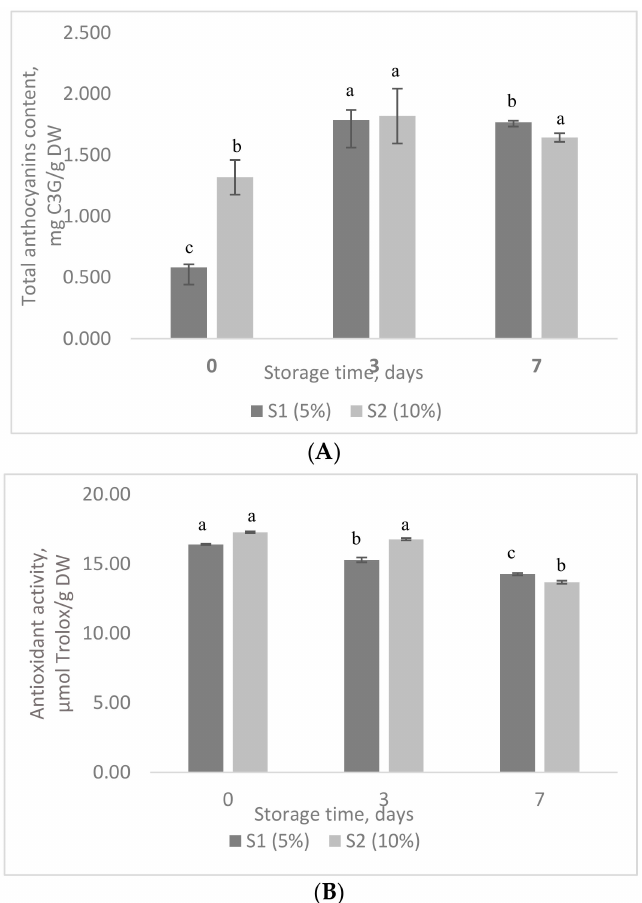
Figure 4. The stability of anthocyanins ( A ) and antioxidant activity ( B ) in marshmallows samples during storage test. Superscripts that for the same sample do not share the same letter (a, b, c) are statistically significant at p <